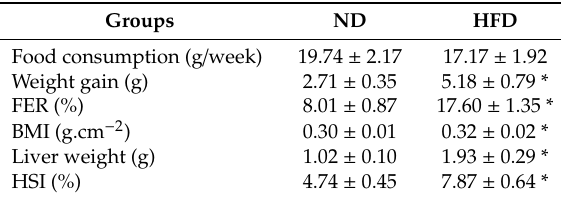
Table 1. E ff ects of high fat-diet on biometric variables and consumption in C57BL / 6J mice. Table 1. Effects of high fat-diet on biometric variables and consumption in C57BL/6J mice. Groups Groups